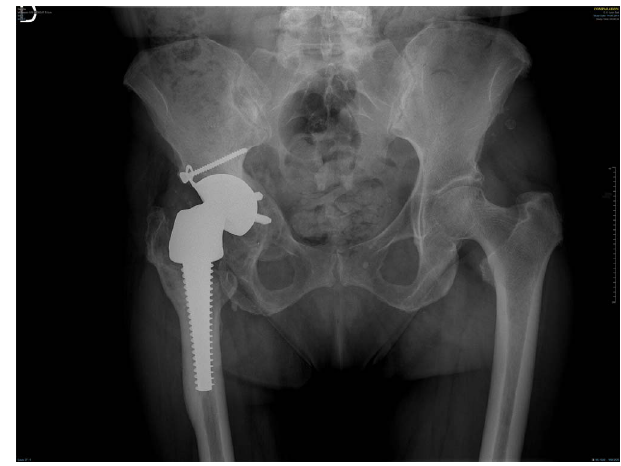
Figure 1. AP view of the pelvis taken in